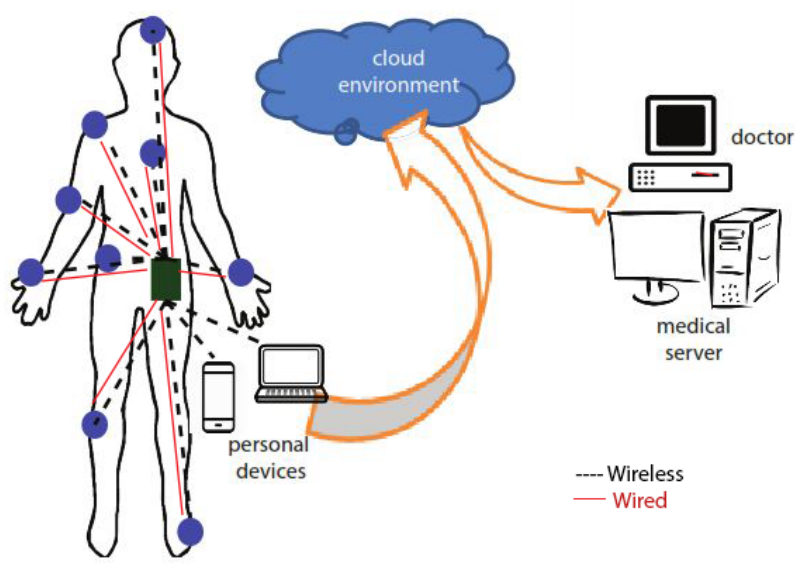
Figure 1. Generic body sensor network